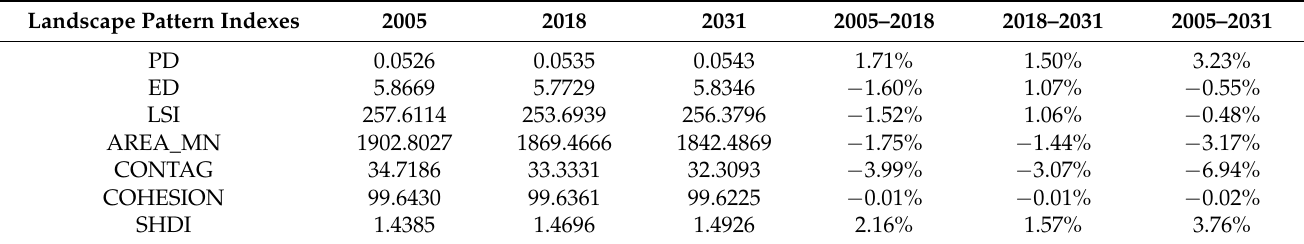
Table 4. Landscape pattern indexes of Yellow River Basin.